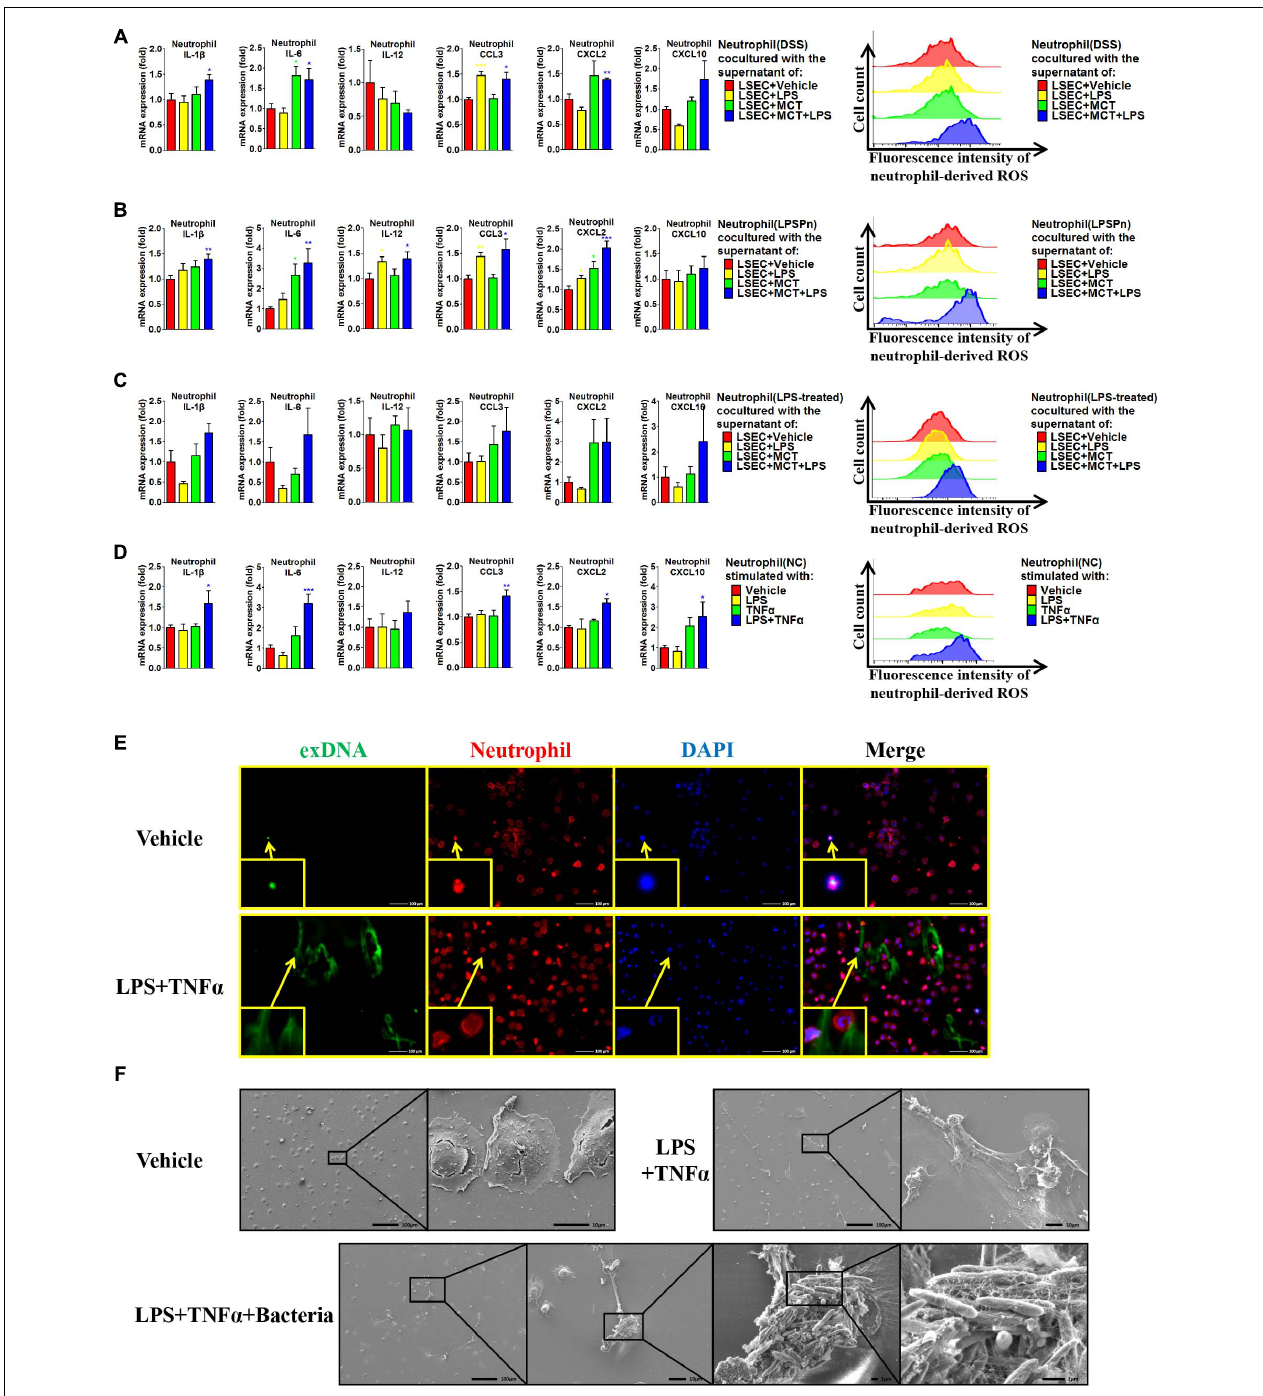
FIGURE 7 | Liver sinusoidal endothelial cells (LSECs) and lipopolysaccharide (LPS) contribute to neutrophil activation. The activation status of neutrophils was evaluated via neutrophil-derived cytokines and neutrophil-derived reactive oxygen species (ROS) in the following experiments: (A) neutrophils were isolated from dextran sulfate sodium (DSS) colitis rats and incubated with the supernatants of LSECs under different treatments [vehicle, LPS, monocrotaline (MCT), and MCT + LPS]; (B) neutrophils were isolated from LPS-induced pneumonia (LPSPn) rats and incubated with the supernatants of LSECs; (C) neutrophils from normal control (NC) rats were pre-treated with LPS and then incubated with the supernatants of LSECs; (D) neutrophils isolated from NC rats were stimulated with LPS, TNF- α , or the combination treatment. (E) Neutrophil extracellular traps (NETs) were detected by immunocytochemistry of neutrophil-derived extracellular DNA (exDNA, green). (F) Scanning electron microscopy was used to evaluate the morphology of NETs and its function of capturing bacteria. Asterisk indicates that the level is significantly different with normal control. * p < 0.05; ** p < 0.01; *** p < 0.001 by t -test; n = 6 in each group; figures are representative of three experiments.